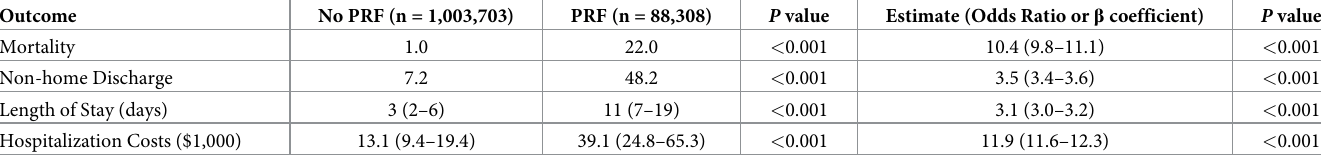
Table 2. Unadjusted and adjusted outcomes stratified by presence of postoperative respiratory failure (PRF). Outcome